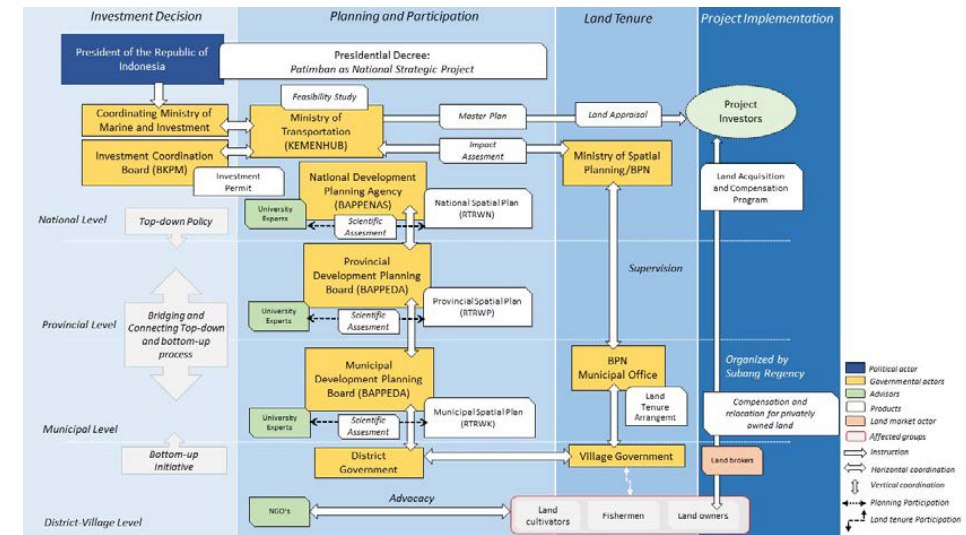
Figure 4. Formal Requirements for Infrastructural Projects (own representation).